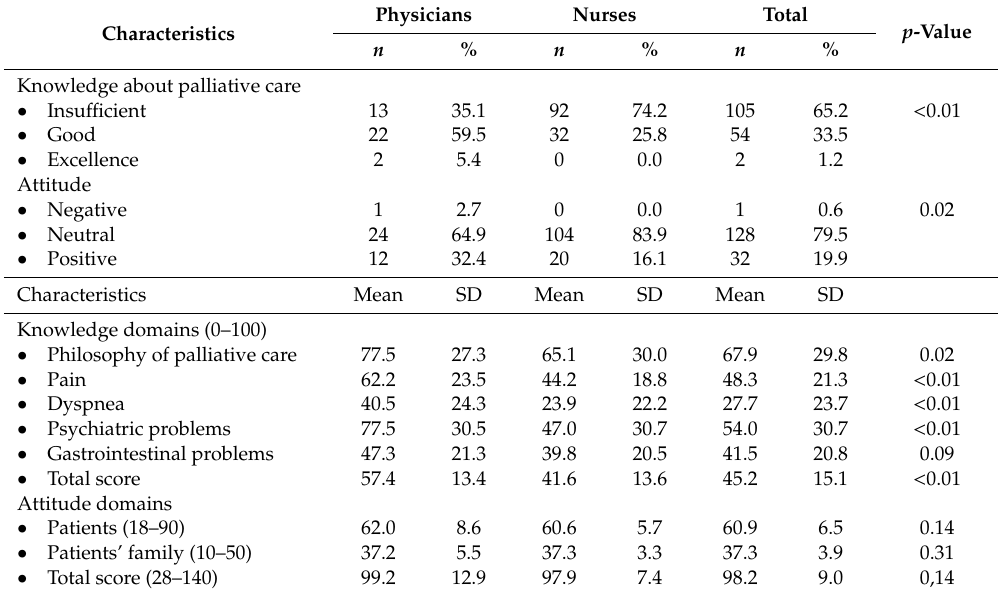
Table 2. Knowledge and attitude toward palliative care among health professionals.